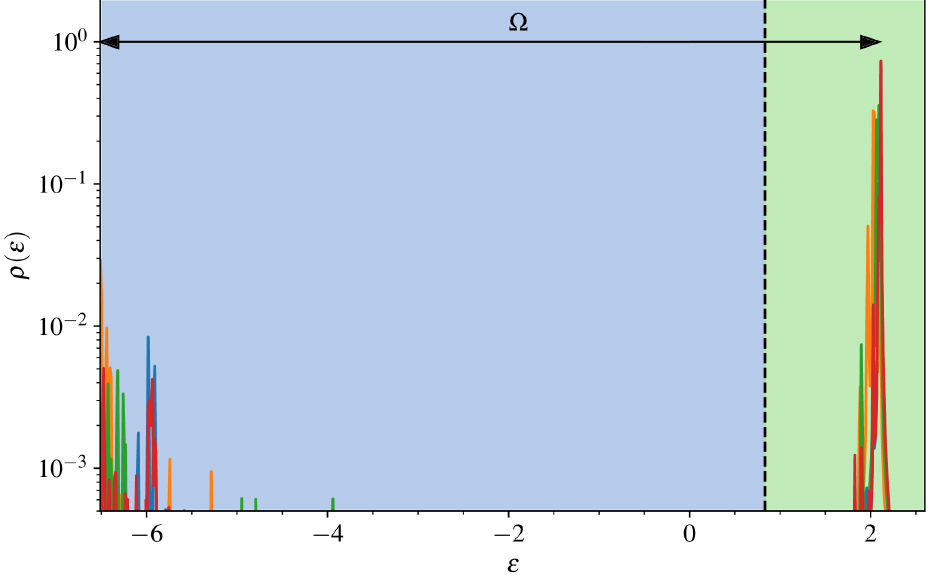
Figure 5: Spectral decomposition of the Floquet multifractal states. The spectral density of states ρ ( (cid:34) ) for typical Floquet multifractal states chosen at random (different colors) show overwhelming contributions from the static eigenstates separated by (cid:34) = Ω . The blue and green shaded regions correspond to the localized and delocalized part of the undriven spec- trum, respectively. The black dashed line denotes the mobility edge, states near which do not get affected by the Floquet drive. The parameters correspond to Fig.